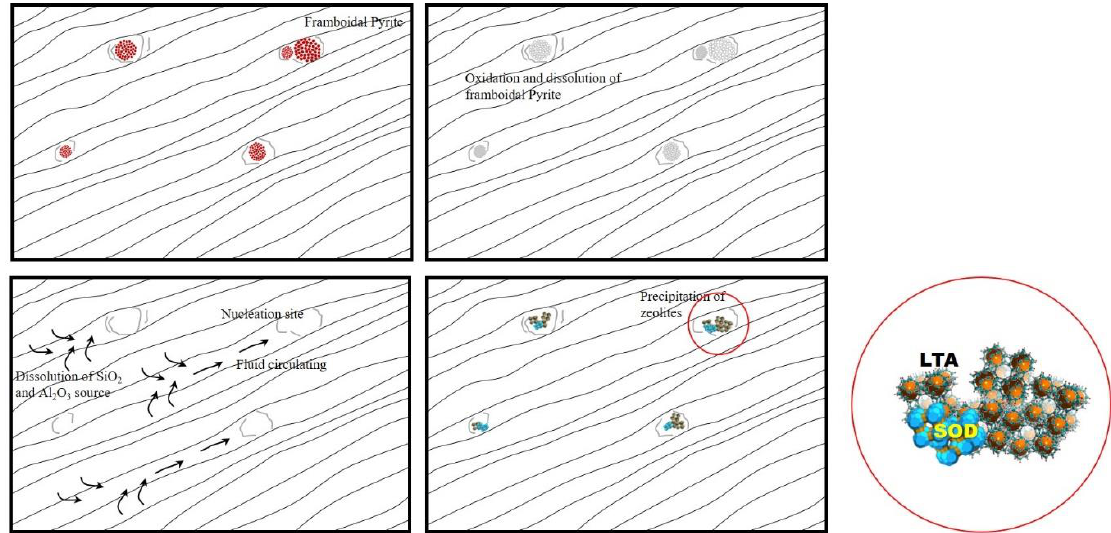
Figure 9. Sketch showing the reconstructed sequence of mineral reactions taking place in the studied mudstone and reg- olith.